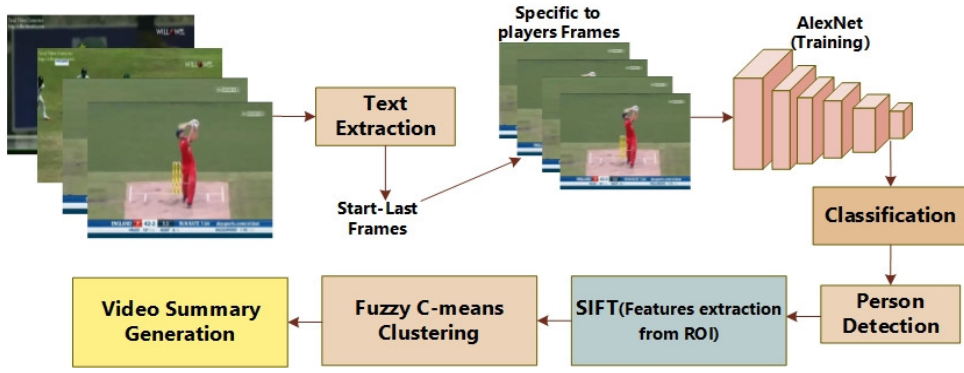
Figure 1. Block Diagram of the proposed system.